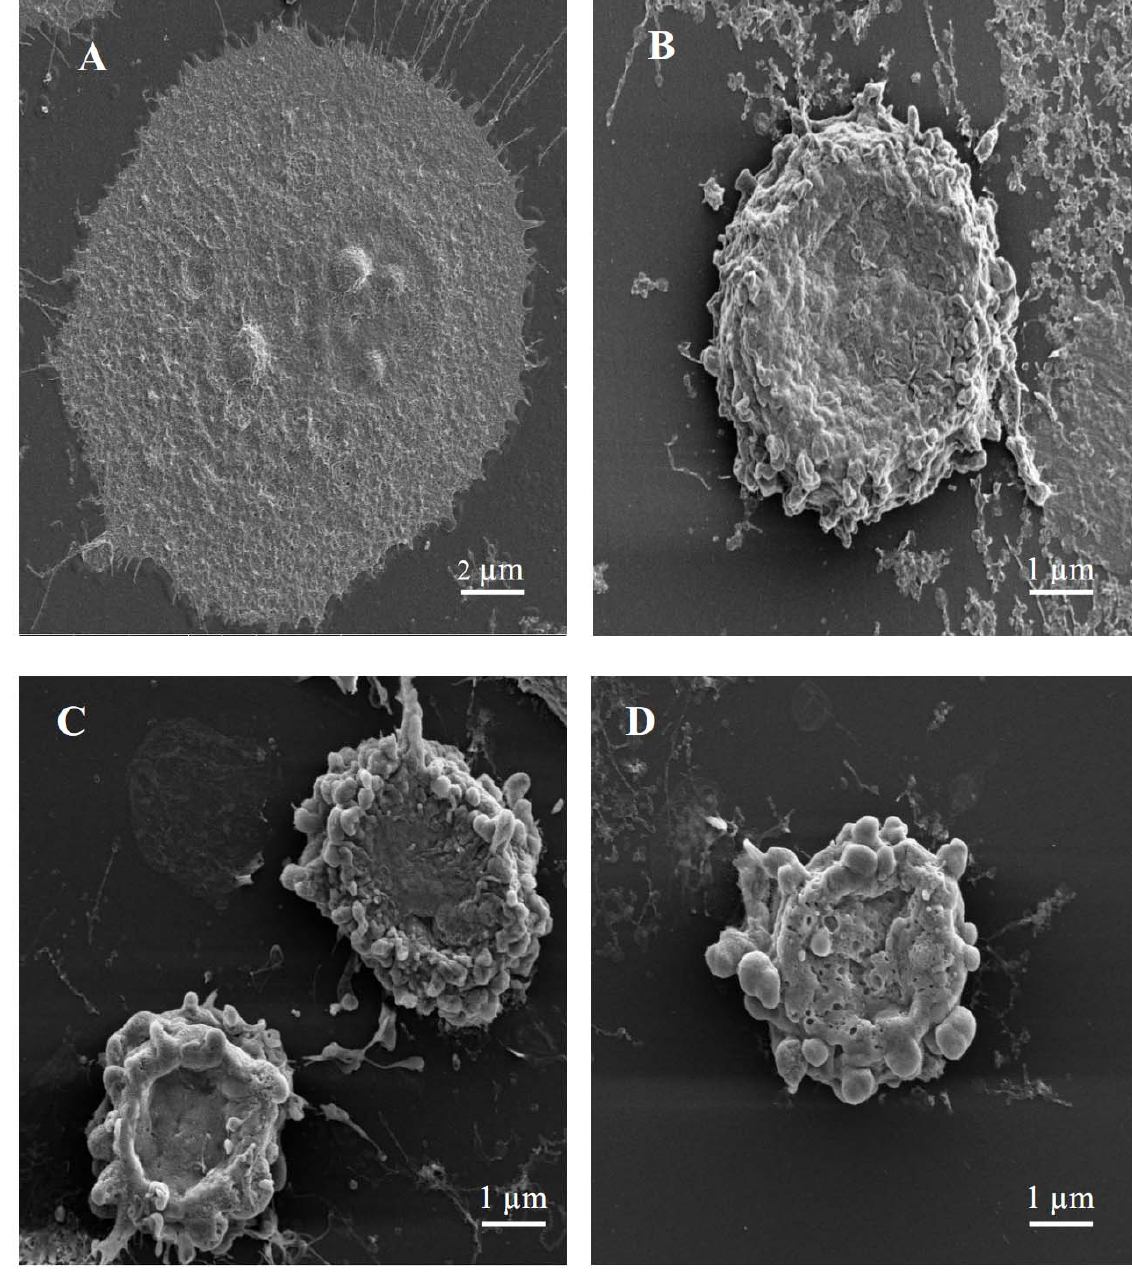
Figure 2. Scanning electron micrographs of MCF-7 cells. ( A ) Untreated cells; ( B ) Cells